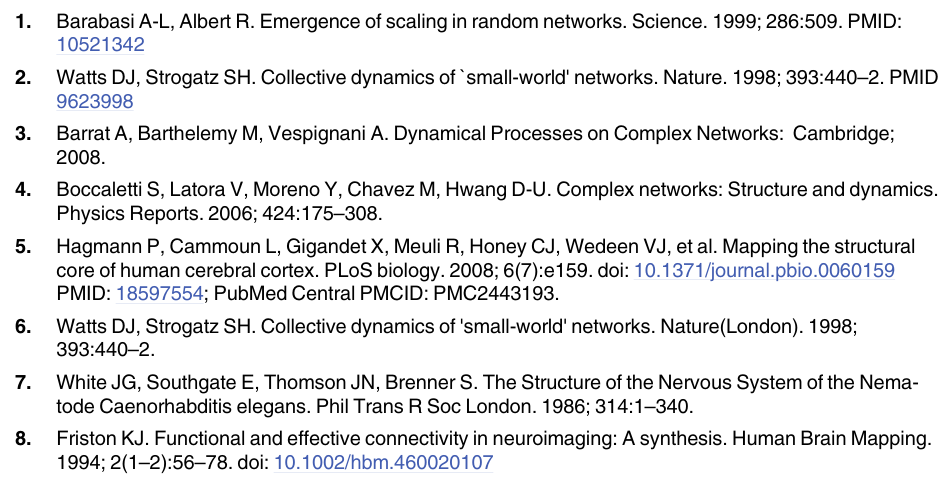
S1 Table. Medication status of MDD group. S2 Table. Semi-metric percentages for ASC vs control groups at wavelet scale 3. S3 Table. Semi-metric percentages for MDD vs control groups at wavelet scale 3. S4 Table. Semi-metric percentages for ASC vs control groups at wavelet scale 4. S5 Table. Semi-metric percentages for MDD vs control groups at wavelet scale